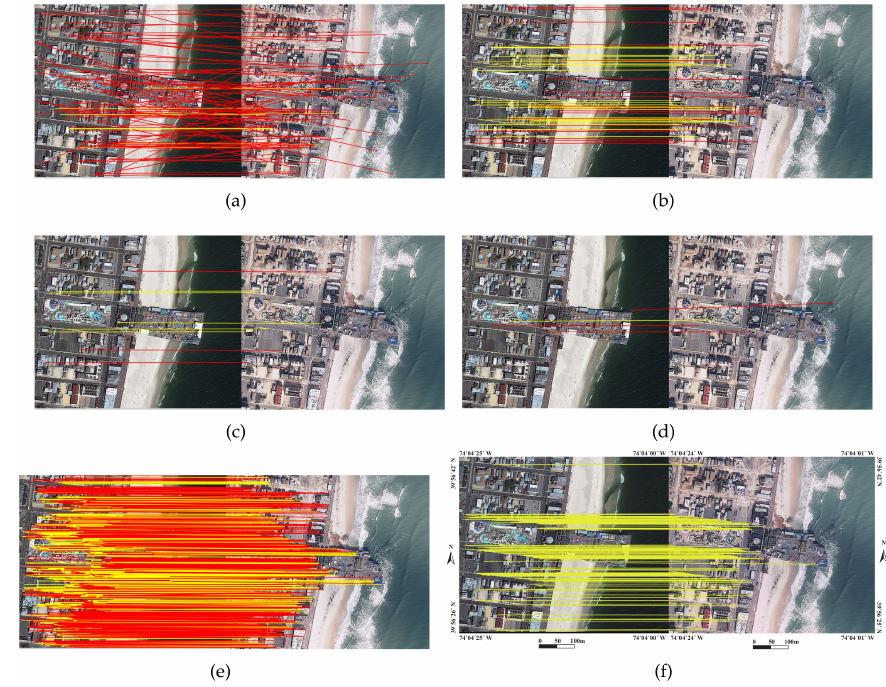
Figure 10. Matching results of image pair 2. ( a ) SIFT; ( b ) LP; ( c ) MSLD; ( d ) RLI; ( e ) LJL; ( f ) Proposed.